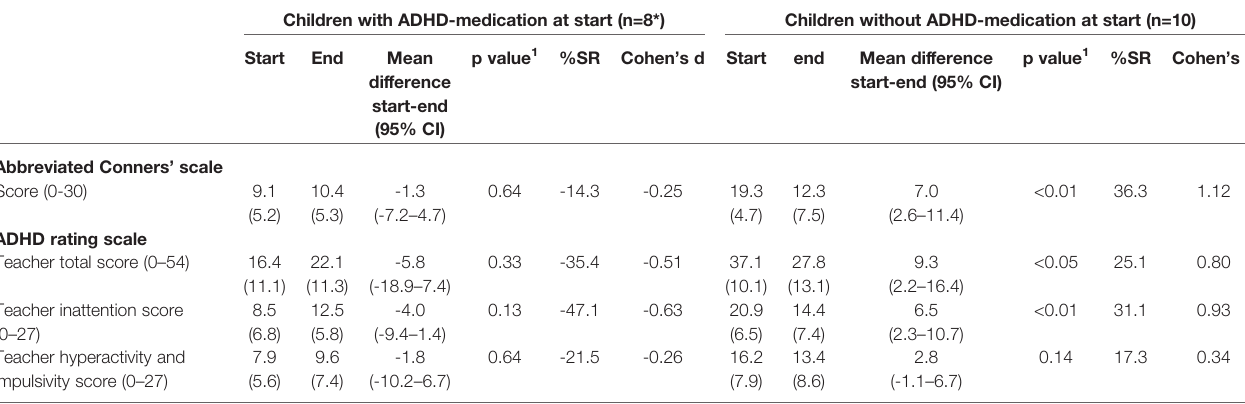
TABLE 4 | Teacher measurements at start and end of the few-foods diet (per protocol) in groups of children with and without taking medication at start.